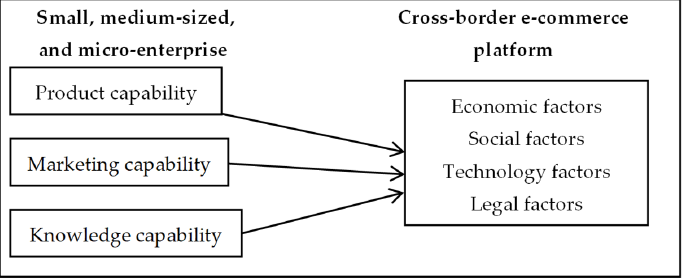
Figure 3. Research model.